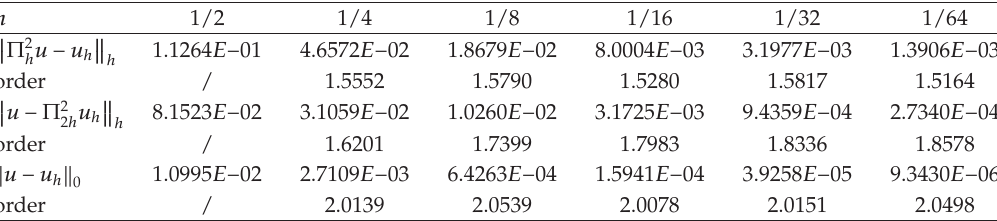
Table 2: The error estimates for nonconforming FE